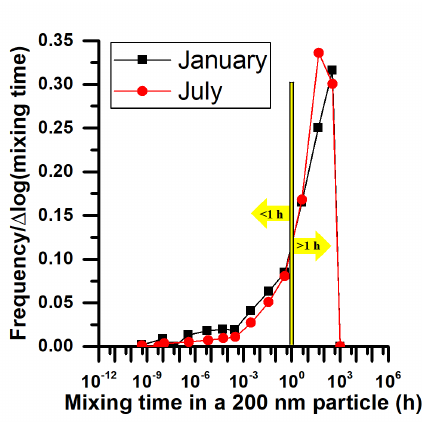
Figure 9. Normalized frequency distributions of mixing times within α -pinene SOA in the planetary boundary layer (PBL) for the parameterization generated using the viscosity data from Zhang et al. (2015). Black symbols correspond to January and red sym- bols corresponds to July. Frequency counts in the PBL were only included for the conditions where the mass concentration of total or- ganic aerosol was > 0 . 5µgm − 3 at the surface. The viscosity param- eterization used to calculate mixing times was based on α -pinene SOA generated using mass concentrations of ∼ 70µgm − 3